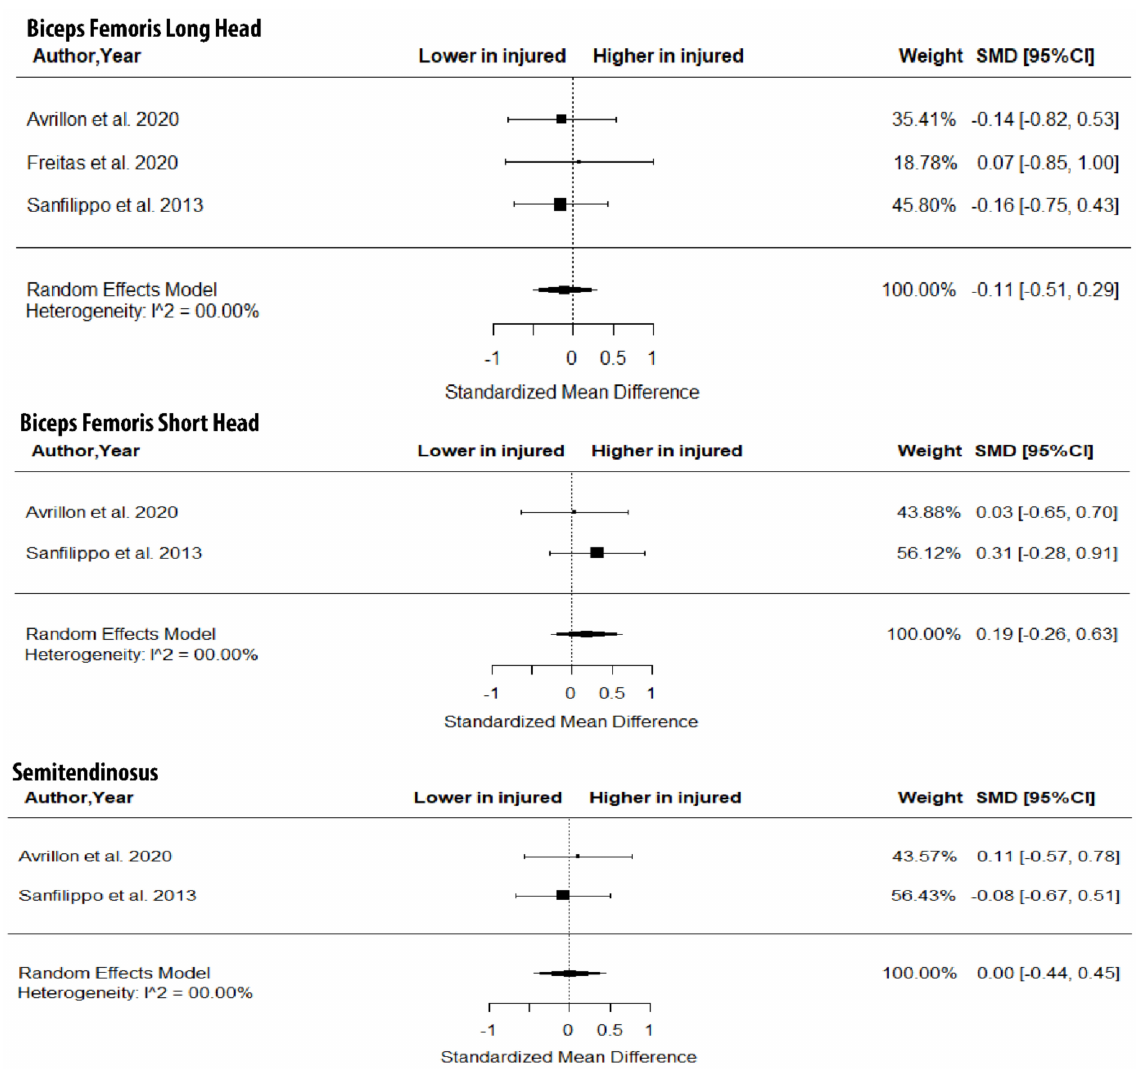
Figure 4. Forest plot of differences in volume of biceps femoris long and short heads and semitendi- nosus between individuals with a previous hamstring strain and